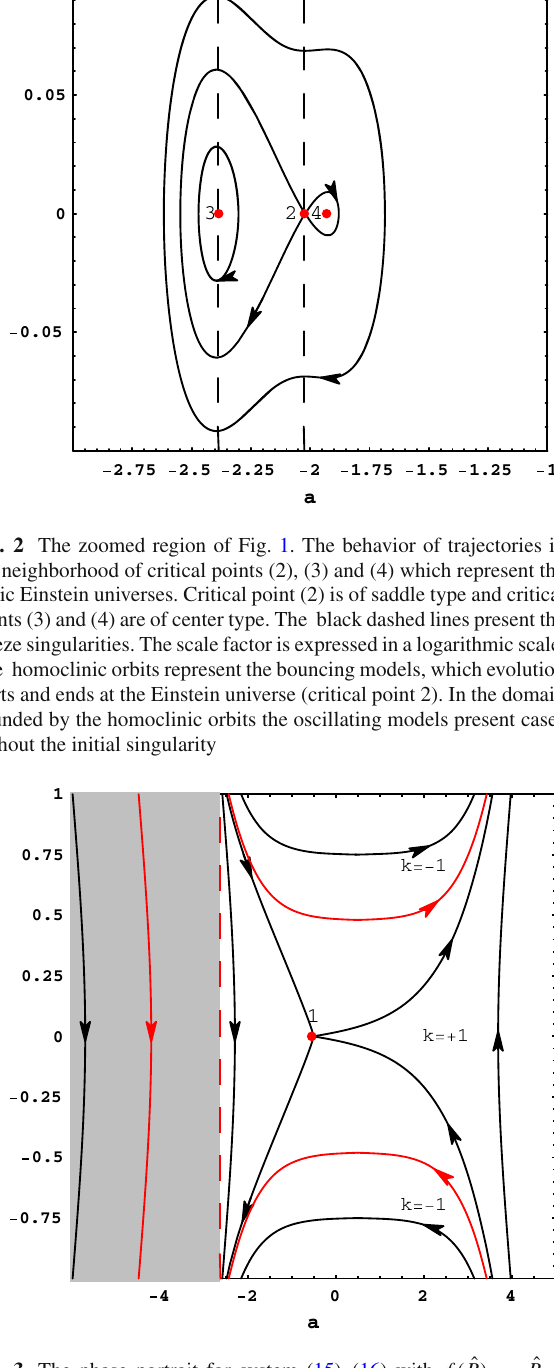
(cid:3) (cid:4) (cid:3) (cid:4) s 2 Mpc 2 s 4 Mpc 4 and δ = − 10 − 14 . km 2 km 4